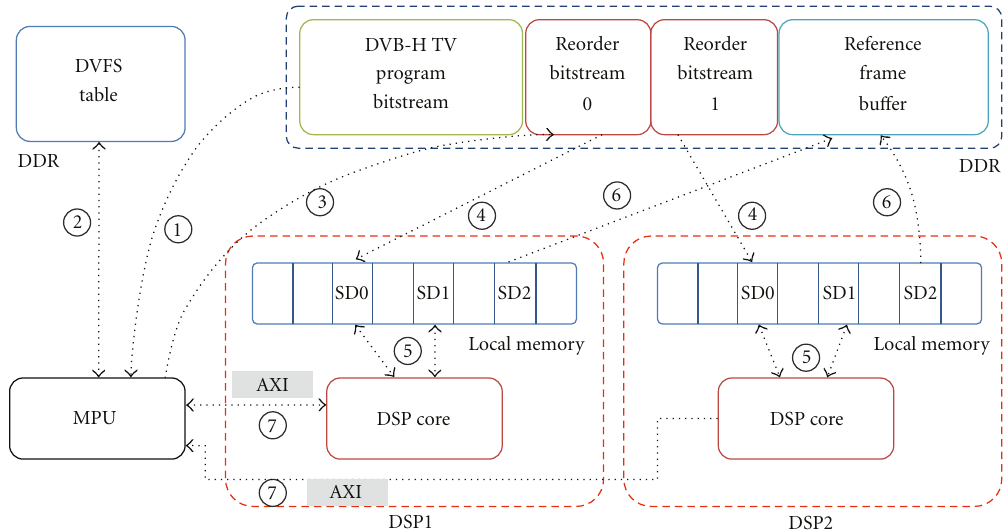
Figure 11: Data Parallel